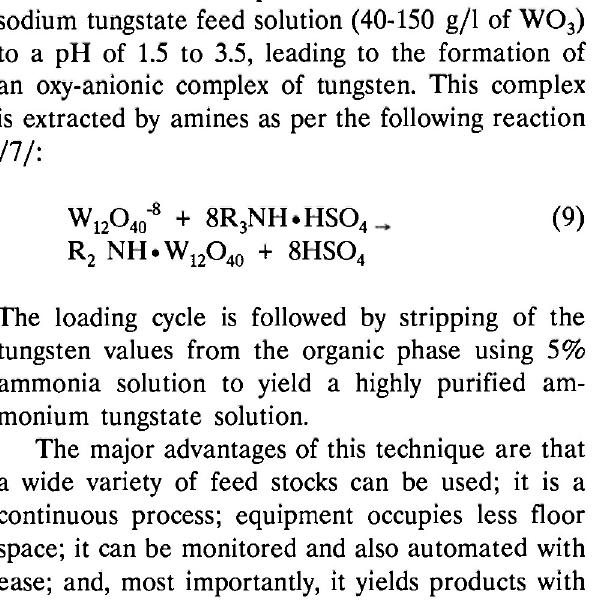
Fig. 3: Principle of cation exchange